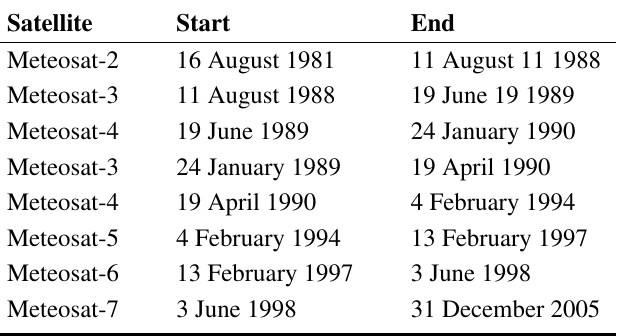
Table 1. History of the Meteosat satellites used to derive the CM SAF SIS